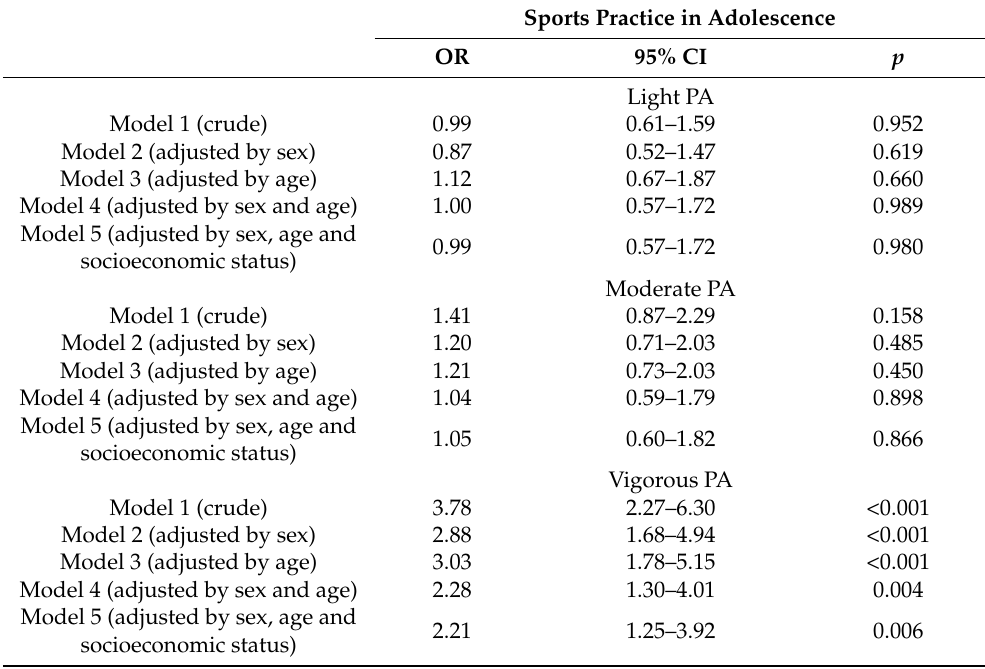
Table 3. Association between sports practice in adolescence with different intensities of physical activity in adult